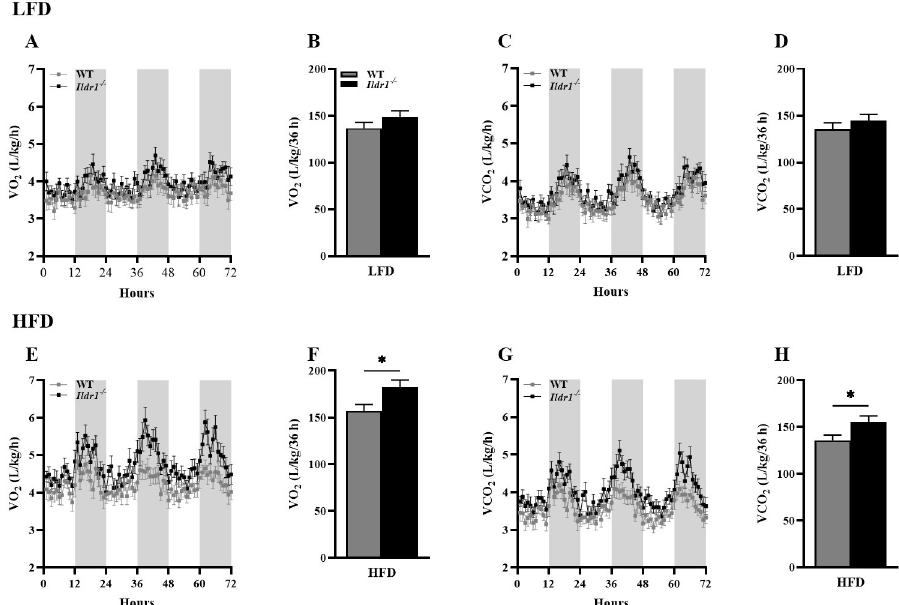
Fig 5. Volumes of oxygen (VO 2 ) inhalation and carbon dioxide (VCO 2 ) exhalation by wild-type (WT, gray) and Ildr1 -/- (black) mice fed either a low (LFD, top row ) or high (HFD, bottom row ) fat diet. (A) VO 2 intake over 72 hr with 12-hr light and dark cycles represented as gray or black bars, respectively, in the LFD groups. (B) Cumulative VO 2 intake during the dark cycle in the LFD groups. (C) VCO 2 exhalation over 72 hr with 12-hr light and dark cycles in the LFD groups. (D) Cumulative VCO 2 output during the dark cycle in the LFD groups. (E) VO 2 intake across circadian cycles in the HFD groups. (F) Cumulative VO 2 intake during the dark cycle in the HFD groups [t(22) = 2.402, P = 0.025]. (G) VCO 2 exhalation over 72 hr with12 hr light and dark cycles. (H) Cumulative VCO 2 output during the dark cycle in the HFD groups [t(22) = 2.324, P = 0.030]. n = 12 mice/genotype/diet; � P < 0.05, WT vs . Ildr1 -/-